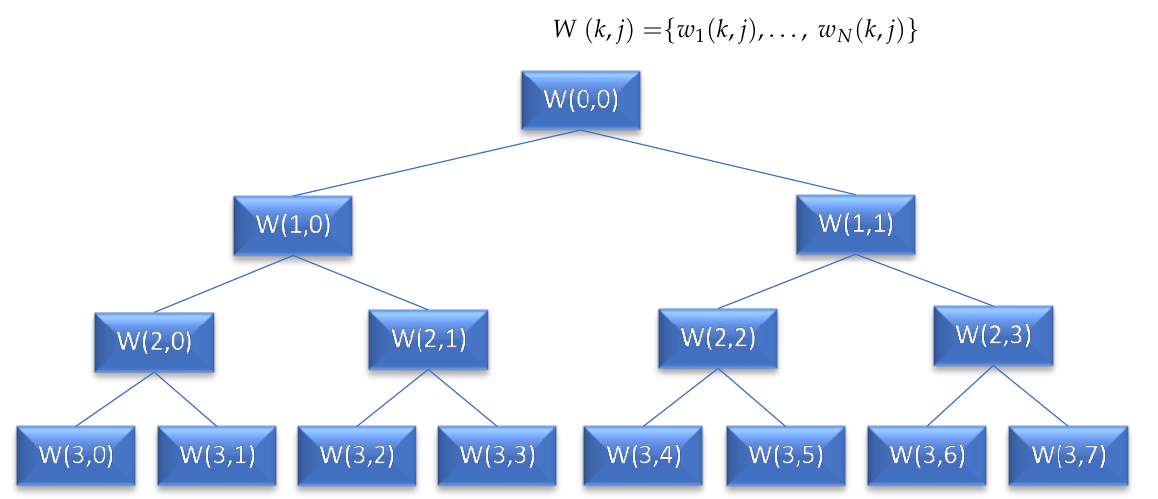
Figure 4. WPT decomposition process for a decomposition level of 3.